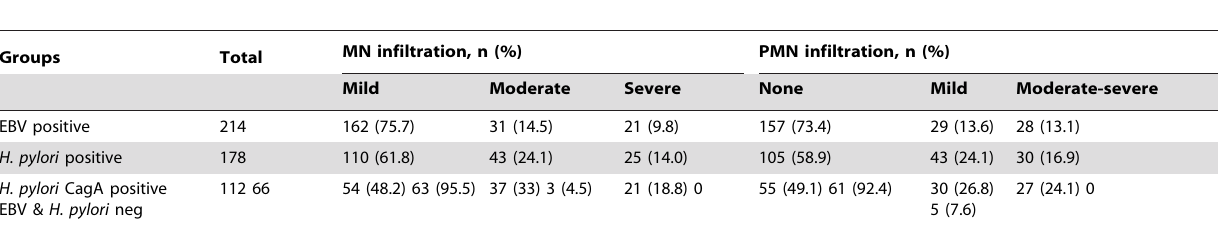
Table 2. Degree of infiltration of MN and PMN cells in the gastric mucosa of children according to infection with EBV and H. pylori .